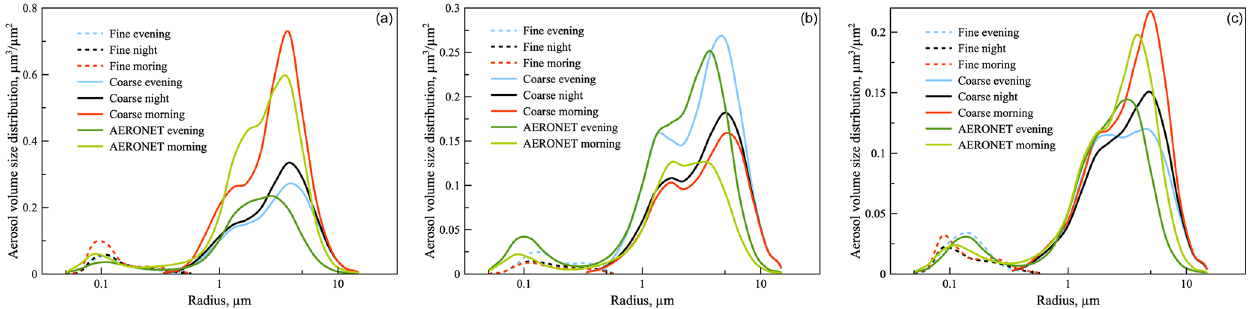
Figure 4. Aerosol volume size distributions for fine (dashed) and coarse (solid) aerosol components retrieved during the COBALD radiosonde flight on 5 August 2015 (a) , 11 August 2015 (b) and 12 August 2016 (c) . Distributions retrieved before and after the radiosonde flight with the use of combined Sun-photometer and MPL data are shown in blue and red, and those retrieved by AERONET are in dark and light green, respectively.